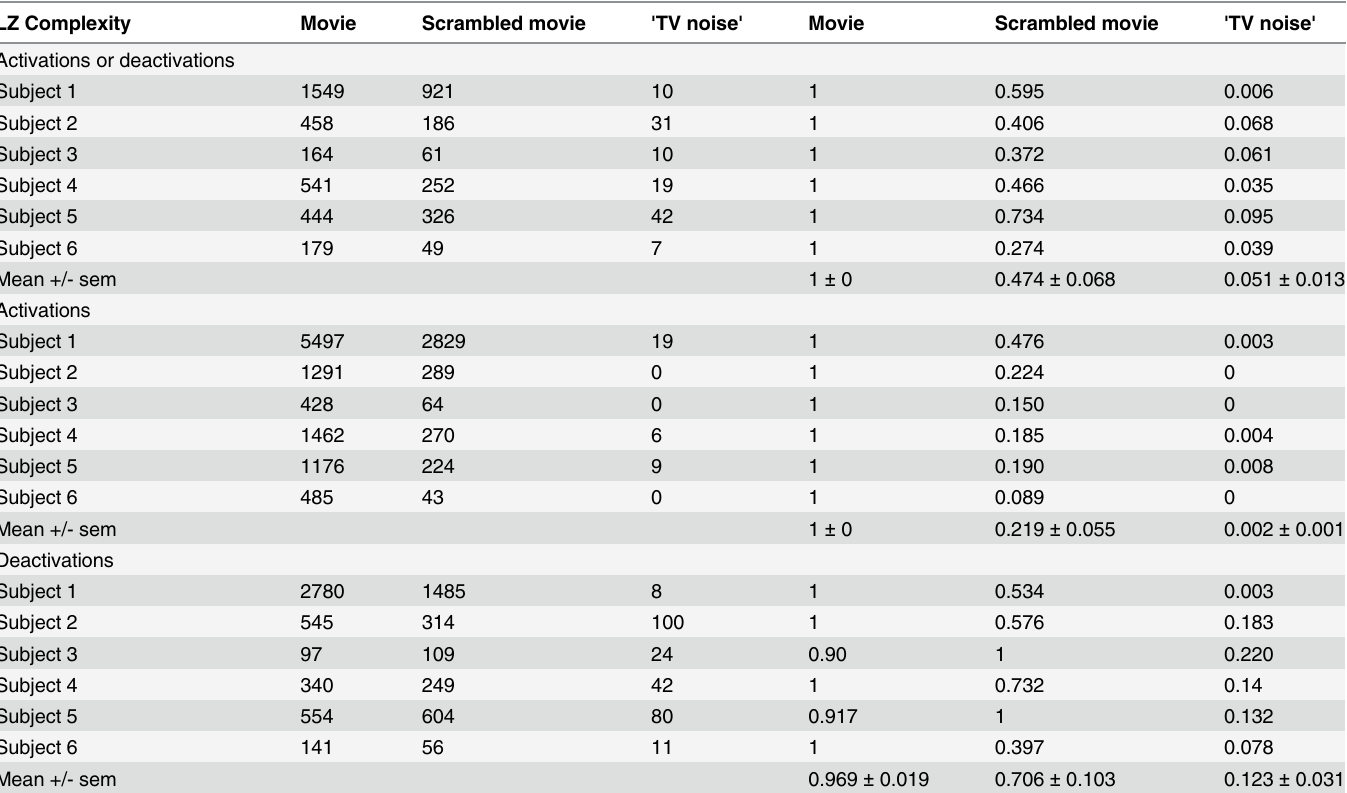
Table 3. fMRI activation/deactivation Lempel-Ziv complexity results — comparison to the session mean. LZ Complexity